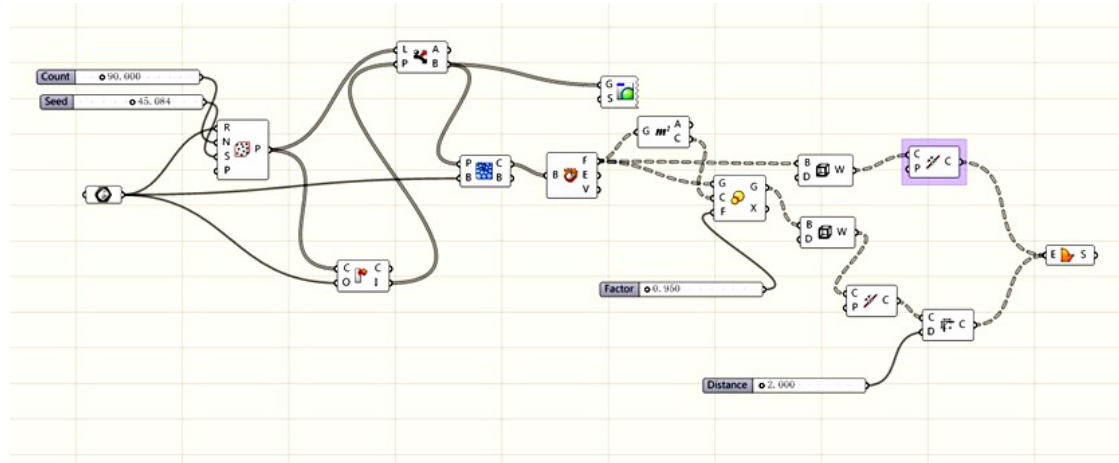
Figure 12. Voronoi structure design process in the filled